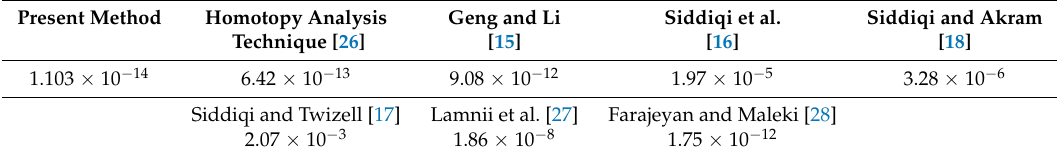
Table 3. Comparisons of maximum absolute errors of the present method with other methods.